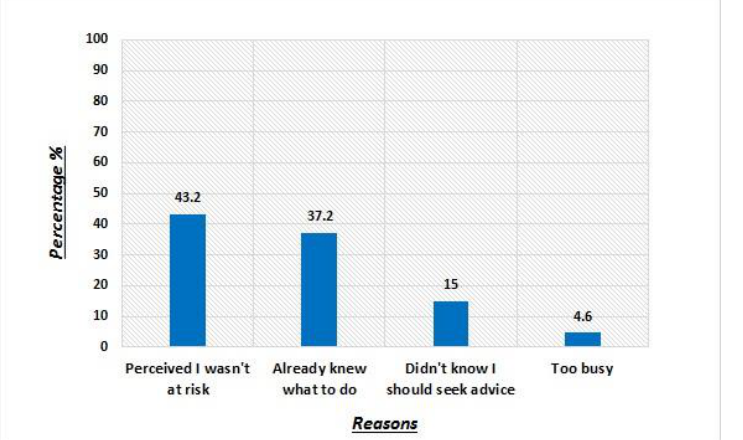
Figure 3. Reasons for not seeking travel health advice for those who did NOT seek